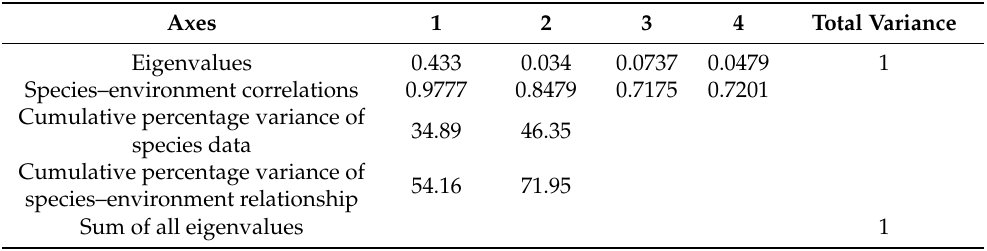
Table 1. Summary of RDA analyses with environment variables explaining phytoplankton assem- blage before the flooding of Huayanghe Lakes.